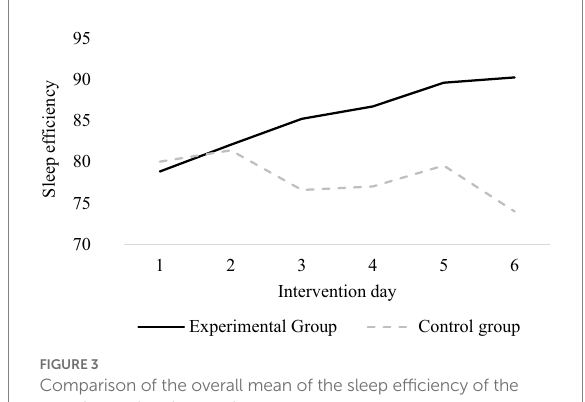
FIGURE 3 Comparison of the overall mean of the sleep efficiency of the experimental and control groups.